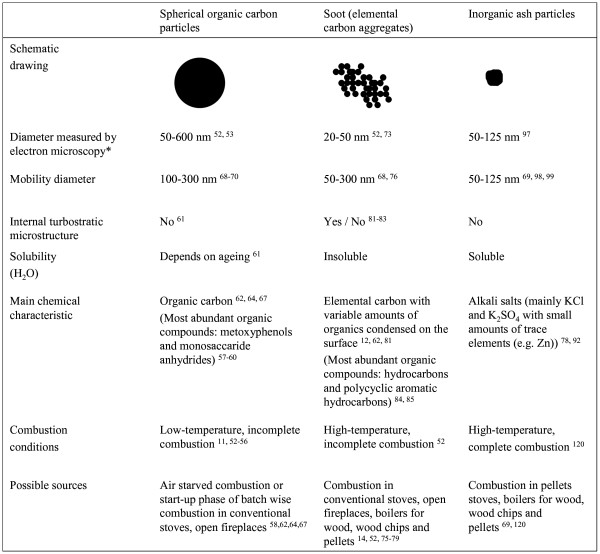
The physicochemical characteristics of the three classes of wood combustion particles. The numbers refer to the references used in the text. * For the aggregated soot particles the listed diameter refers to the primary particle diameter.